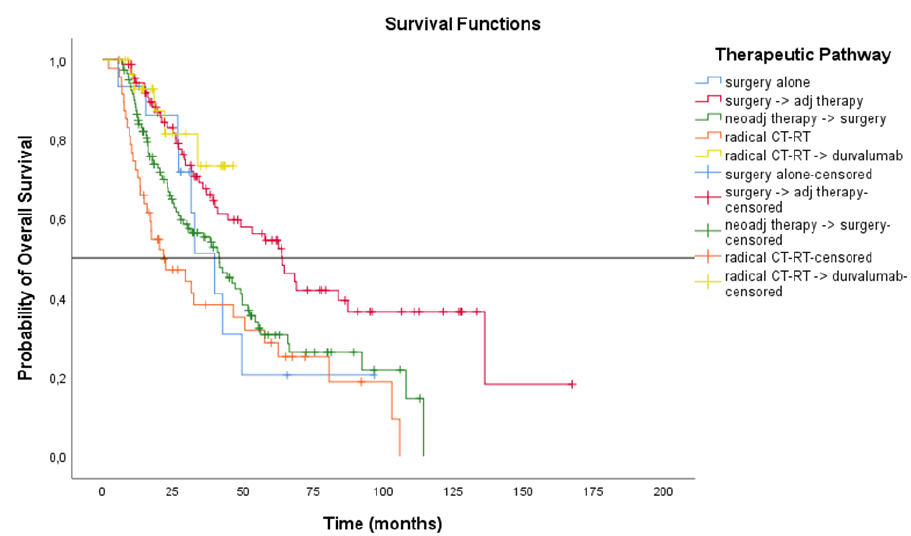
Figure 7. Kaplan–Meier curves of estimated overall survival in the intention-to-treat population as per radical treatment modality. CT-RT, chemo-radiation therapy. Table 4. Survival outcomes as per multimodality therapy.